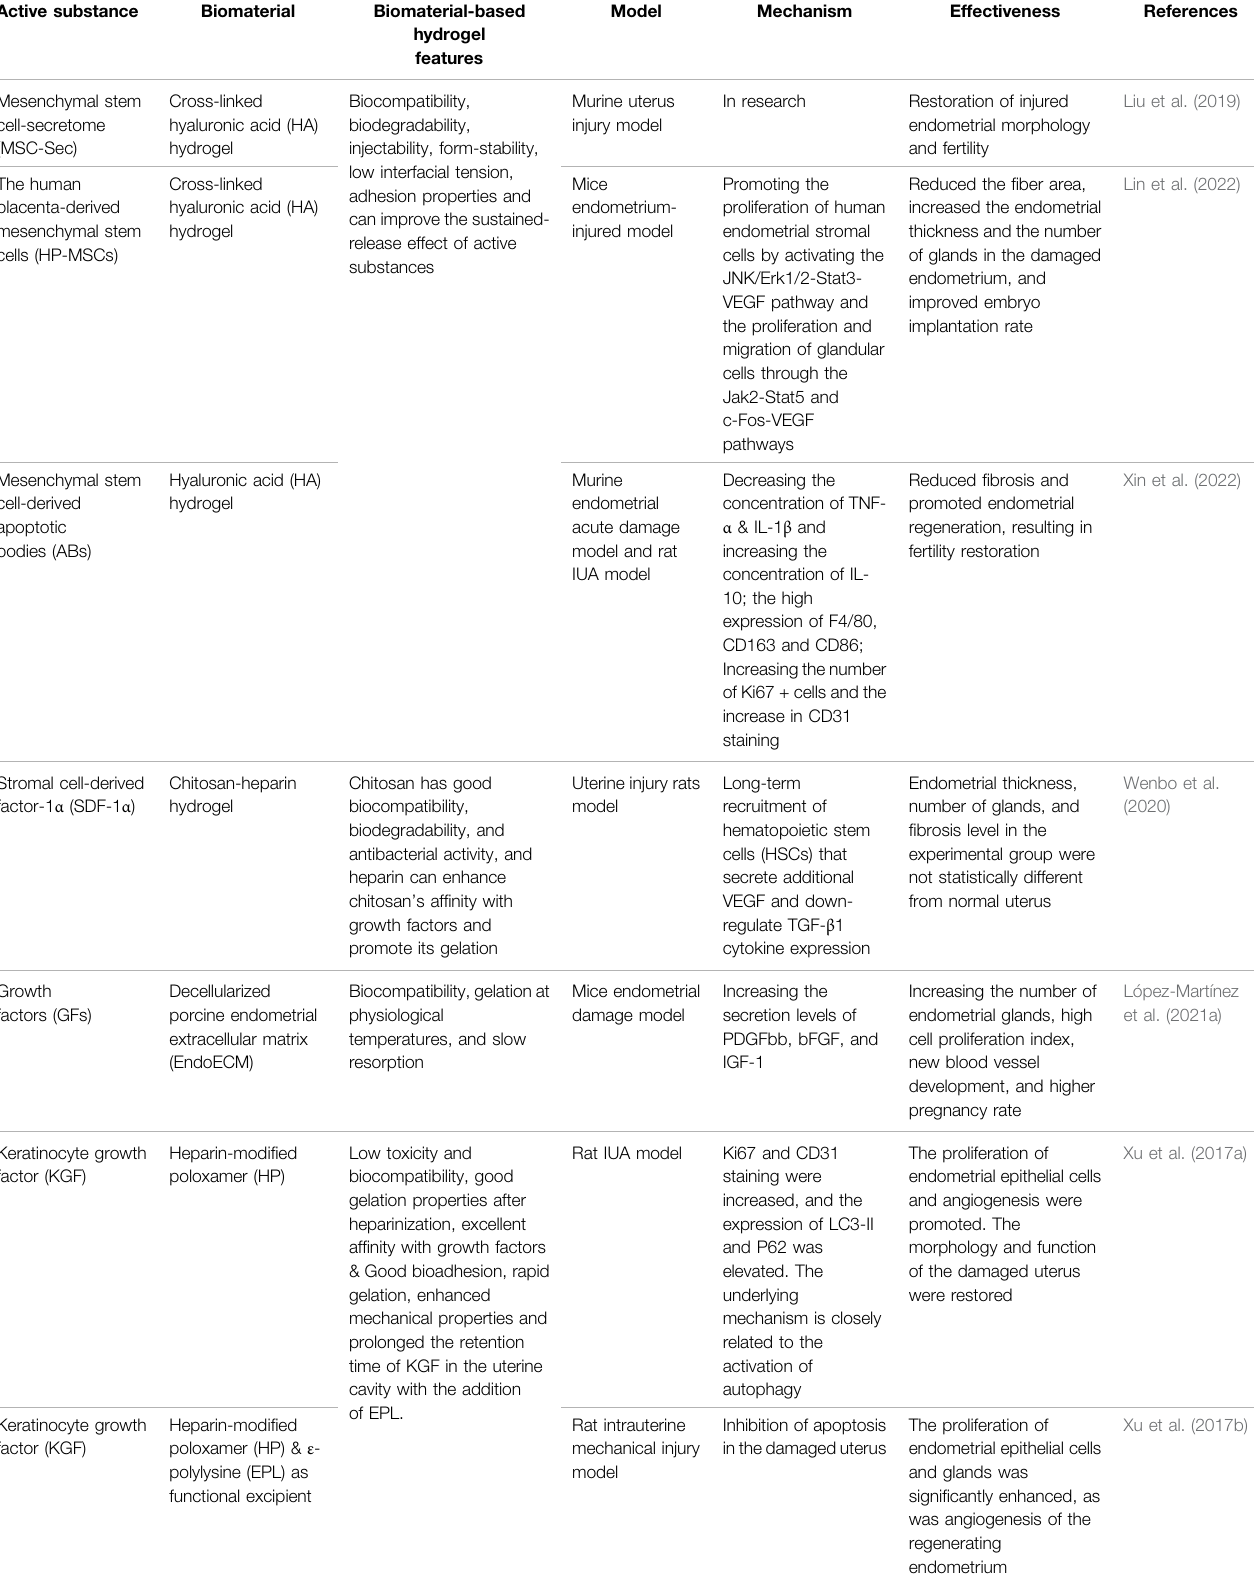
TABLE 1 | Summary of biomaterial-based hydrogels in repair of endometrial